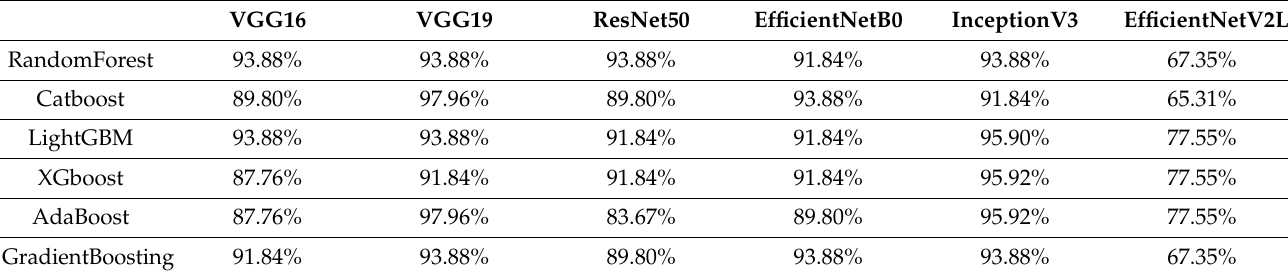
Table A15. Accuracy of each model combination for blue